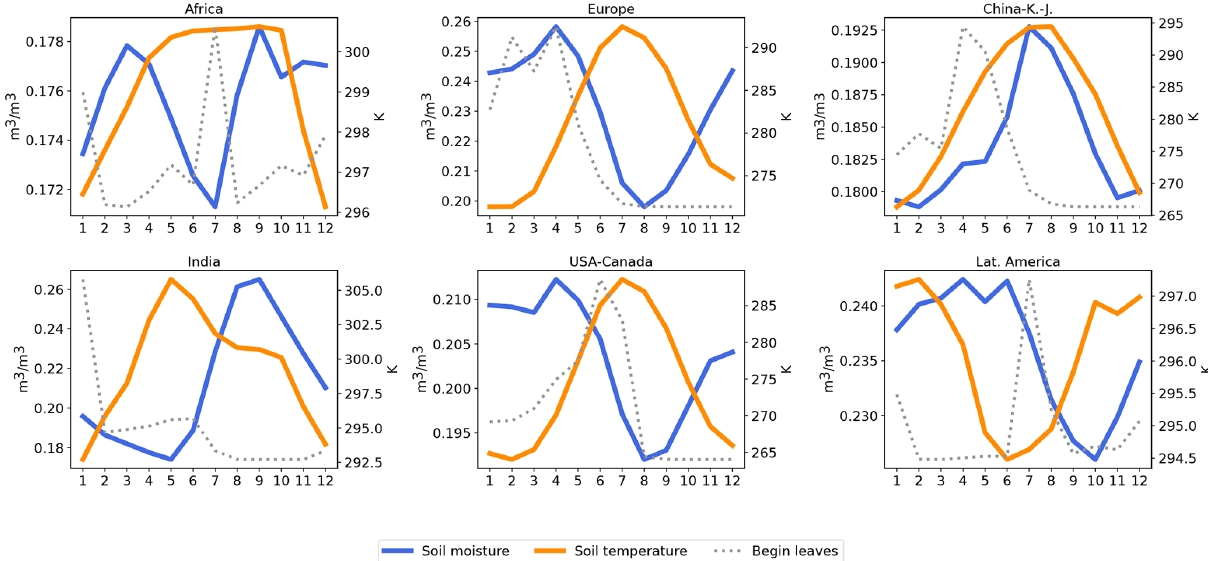
Figure 10. The regional monthly simulated soil moisture (m 3 m − 3 , in blue) and soil temperature (K, in orange). The regional monthly signal for leaves to start to grow in ORCHIDEE averaged over the different PFTs is drawn using dotted gray lines (this metric is unitless and can be seen as a qualitative signal for the start of the vegetation growing season). Variables are for 2006. China–K–J accounts for China, Korea, and